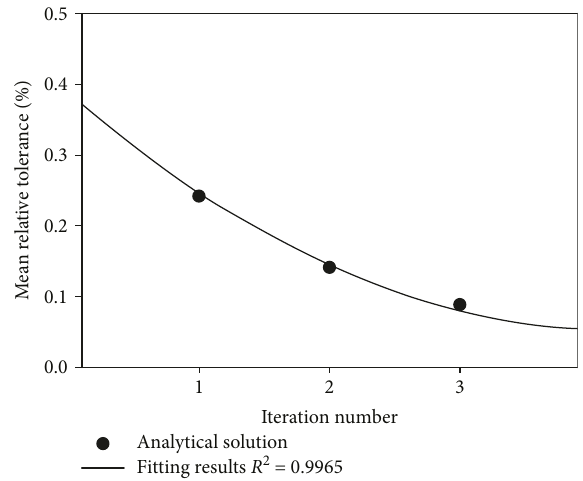
Figure 2: Convergence check for the iterative analytical